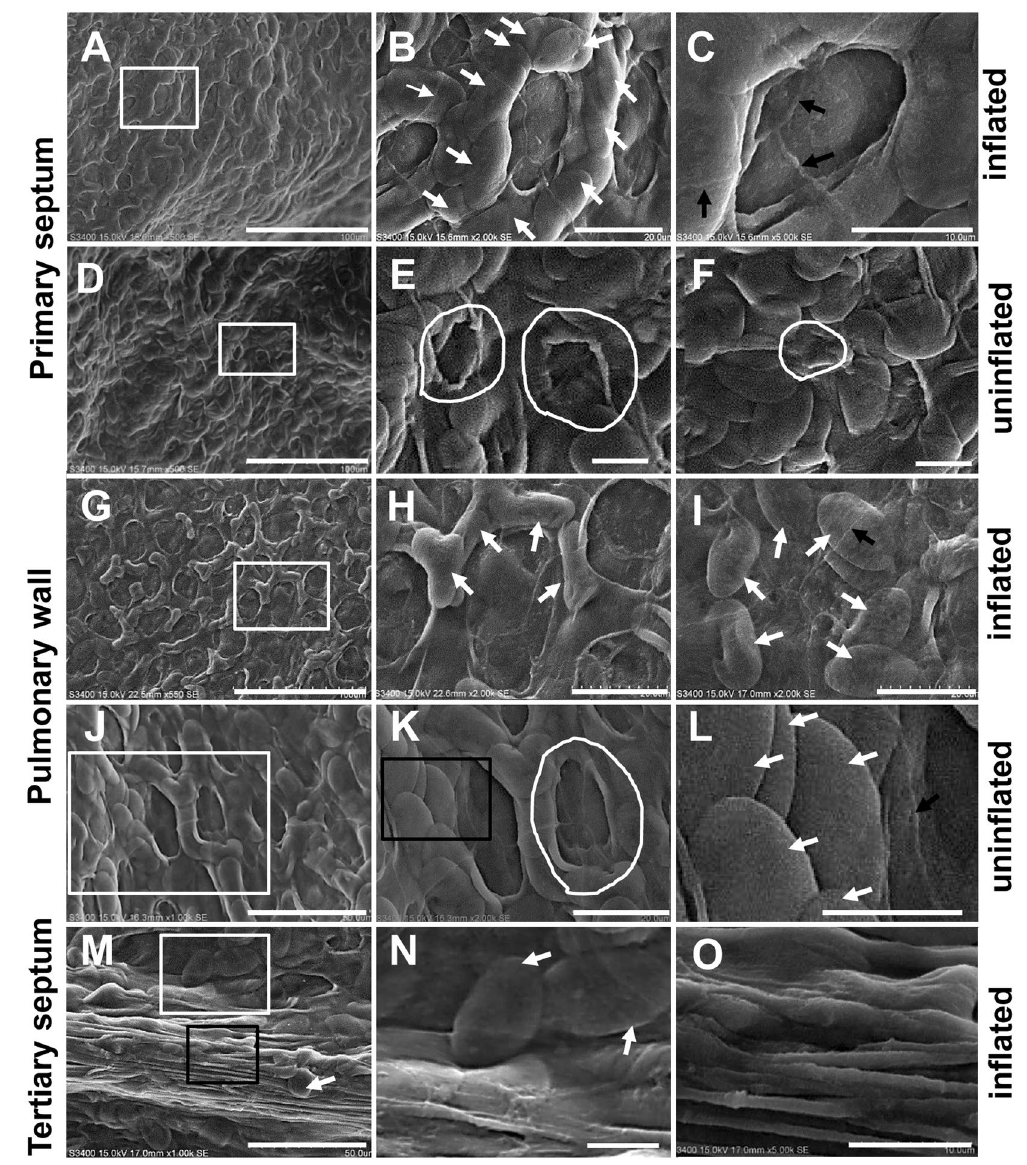
Figure 2. Ultrastructure of septum and pulmonary wall in P.nigromaculatus by SEM. SEM observation of the septa and pulmonary wall in P. nigromaculatus . In the primary septum surface of inflated lungs, the lattice includes sheets and a bottom ( A,B ), and the bottom is smooth ( C ). The uninflated lungs contain sheets and a bottom ( D,E ), and the overlapping sheets completely cover ( F ) or mostly ( E ) cover the bottom. Lattice, sparse sheets, and bottom in the pulmonary wall of inflated lungs ( G,H ). An inconspicuous lattice with a bottom and sheets ( I ) in the inflated lungs. The overlapping sheets ( J,L ) partially cover the bottom ( J,K ) in the pulmonary wall of uninflated lungs. The free end of the tertiary septa contains elongated filaments ( M,O ) and several sheets ( M,N ). B, E, H, K, and N show enlarged images of the white boxes in A, D, G, J, and M, respectively. L and O show enlarged images of the black boxes in K and M, respectively. The white thick arrow indicates a sheet, the black arrow shows the boundary of an epithelial cell, and the white curve shows the lattice in the uninflated lung. Scale bars, A, D, G: 100 μ m; B, H-I, K: 20 μ m; C, E-F, L, N-O: 10 μ m; J, M: 50 μ